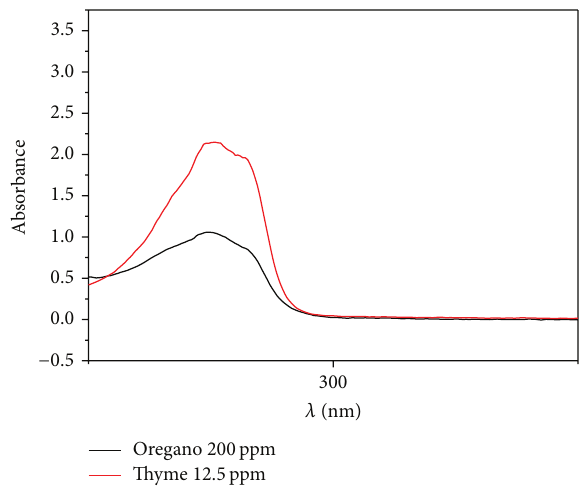
Figure 2: UV comparative spectra of O. vulgare and T. vulgaris essential oils.